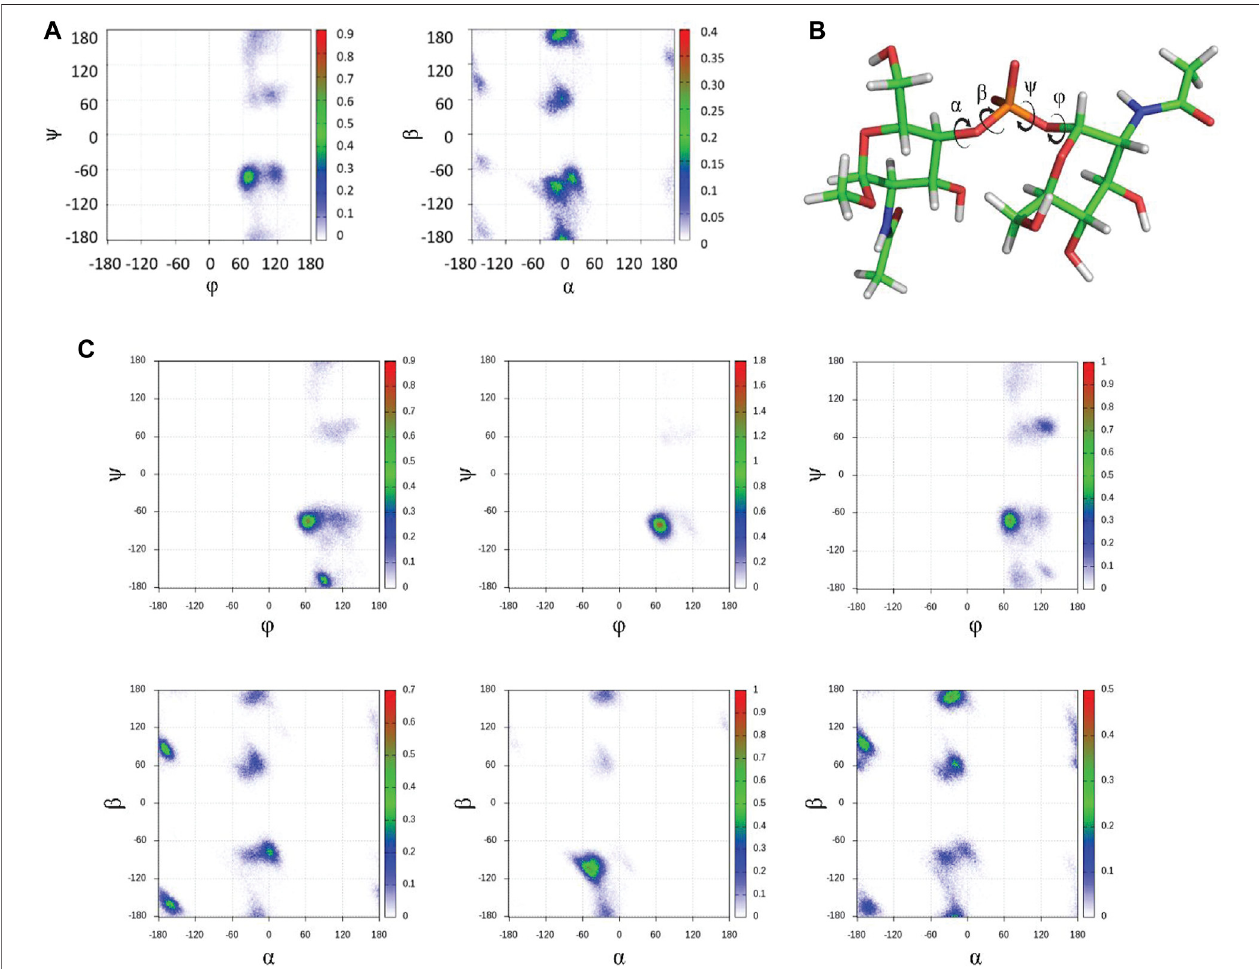
FIGURE2| Insilico conformationalstudiesonMenXCPS. (A) GlycosydiclinkageanalysisforDP2.The φ / ψ and α / β plotsfrom1 μ sMDsimulationsinexplicitwater are shown (GLYCAM06 force fi eld) for MenX DP2. The conformational fl exibility at β is evident, while the other three torsion angles display more restricted motion. (B) Structure of the global minimum for MenX DP2 as determined by MD calculations. (C) Selected φ / ψ and α / β plots for different contiguous disaccharide fragments of MenX DP12 from the 1 μ s MD simulations in explicit water (GLYCAM06) carried out for the dodecasaccharide.